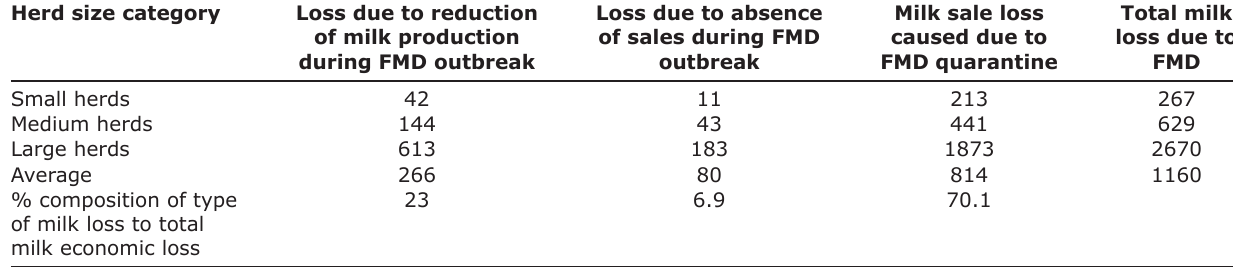
Table-11: Milk production losses in US dollars due to lack of milk sales during FMD outbreaks in case study herds. Herd size category